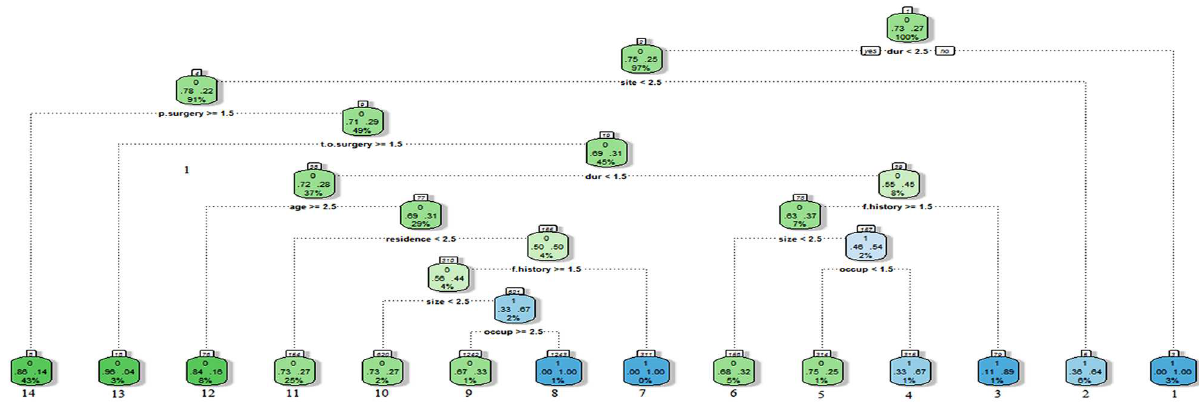
Fig 2. Decision classification of eumycetoma